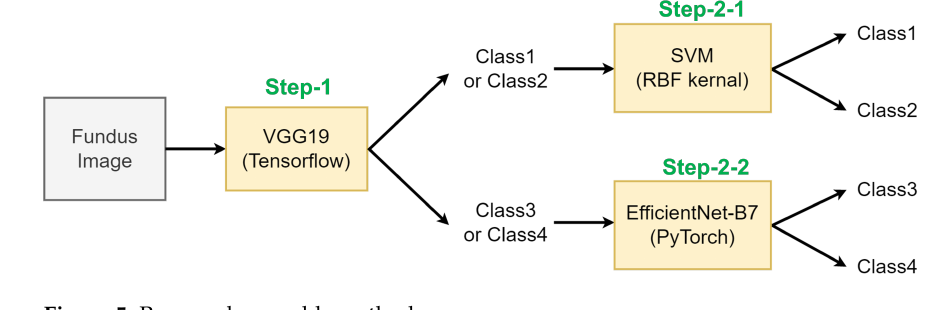
Figure 5. Proposed ensemble method. Table 5. Classification accuracy when three machine learning